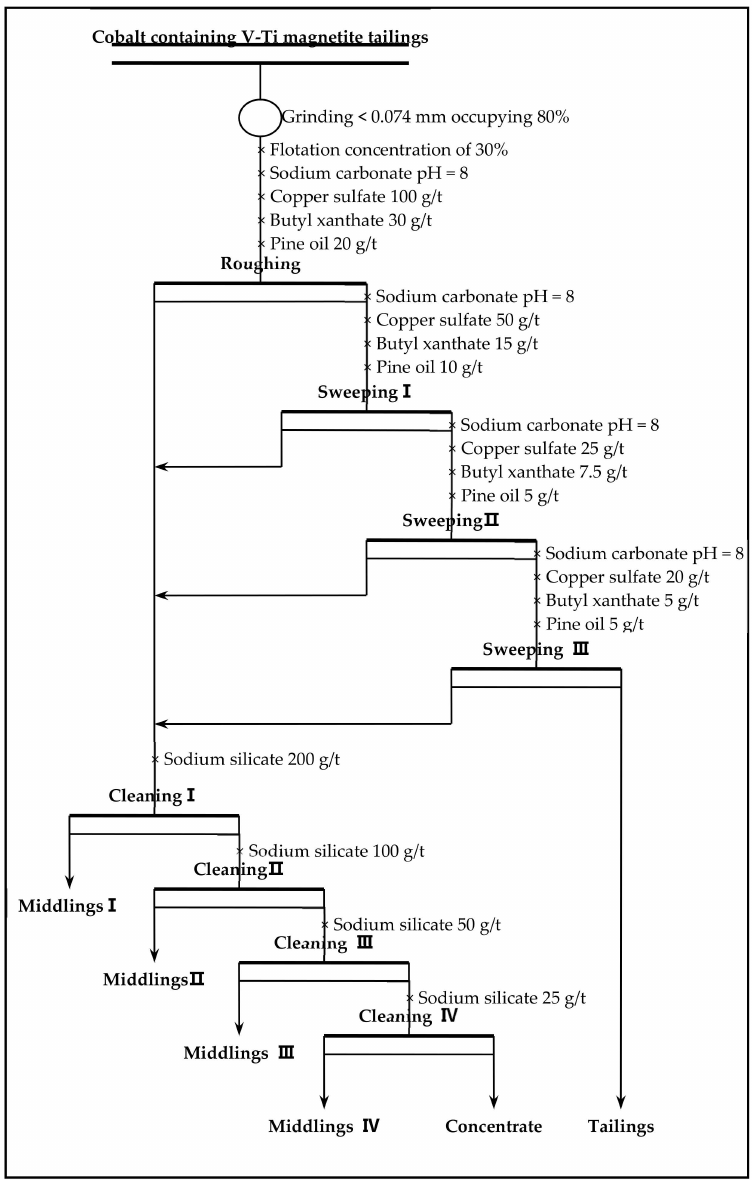
Figure 9. Time on flotation cleaning test